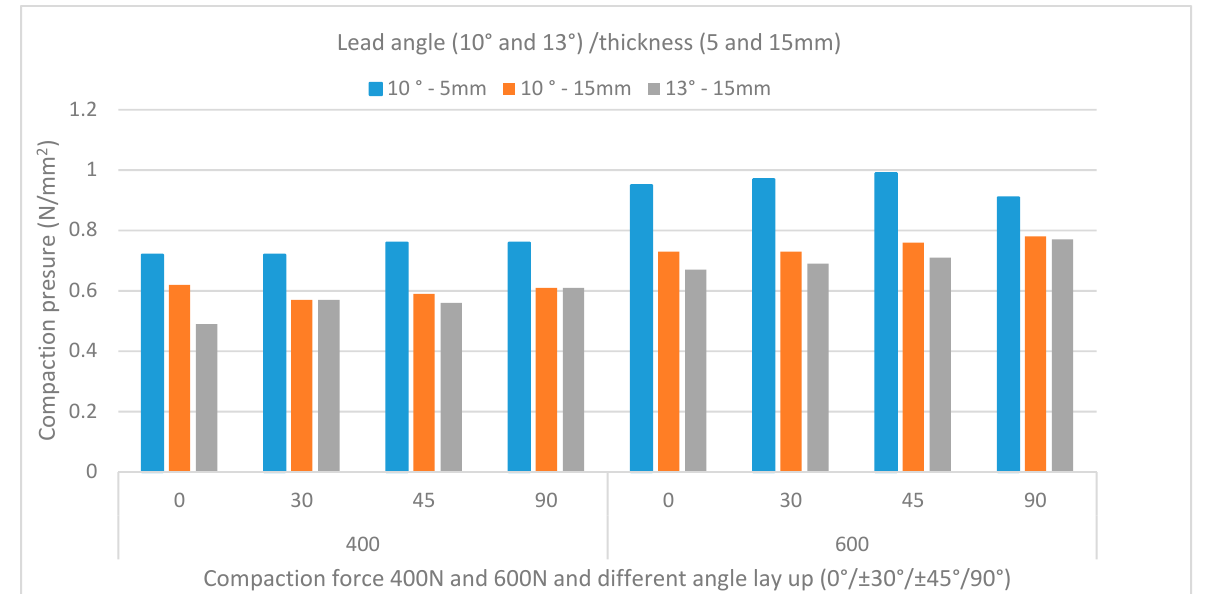
Figure 6. Influence of compact force on the contact line, La, from different angles of laying up; ( a ) for two different lead angles (10 0 and 13 0 ); ( b ) for two rollers of different thicknesses (5 and 15 mm).